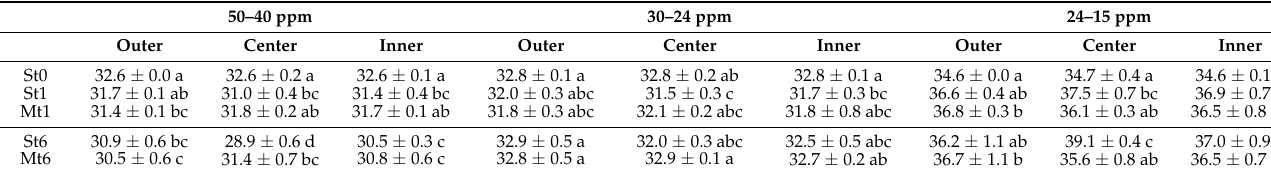
Table 1. Intensity distribution (% of total intensity) in the CPMAS 13 C NMR spectra of the outer, center and inner layer of single-use face masks before (t0) and after 1 and 6 months (t1, t6) of incubation as cuts from a single layer (S) or from a complete mask (M). The values are means ± standard deviations of three NMR measurements obtained from independent replicates. For each chemical shift region, the numbers followed by the same letter indicate no significant differences at the p < 0.05 level.